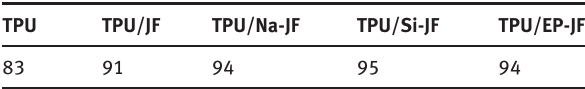
Figure 3: Stress-strain curves of TPU and composites. Table 3: Shore A hardness values of TPU and composites.